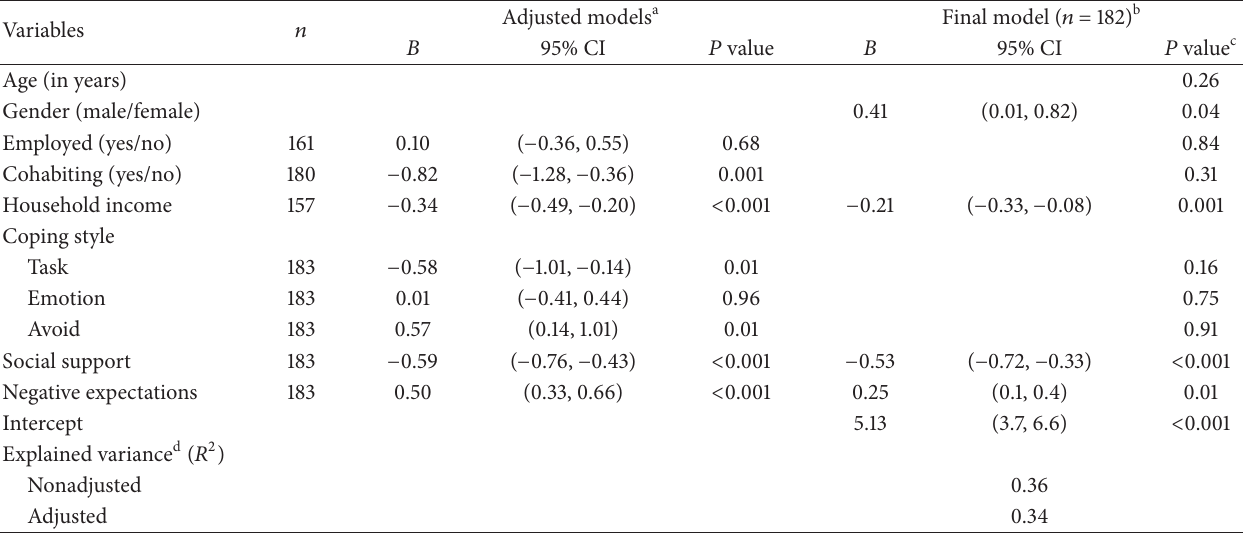
Table 2: Multiple linear regression of coping styles and other predictive factors on emotional status (anxiety and depression complaints) measured at short-term followup (6 months) at Krokeide Rehabilitation Centre, Bergen, Norway, included from 2000 to